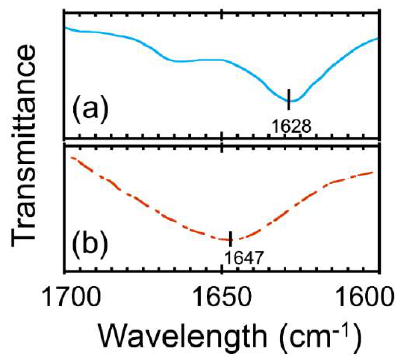
Figure 3. Partial IR spectra of ( a ) poly(Gly– alter –L-Val) and ( b ) Et-Pep (attenuated total reflection, ATR).